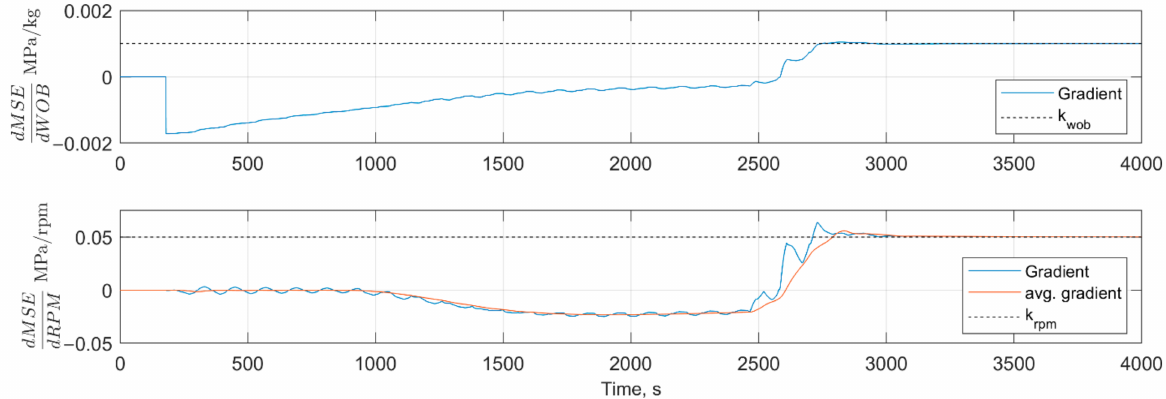
Figure 11. Estimated gradients in Simulation 1.